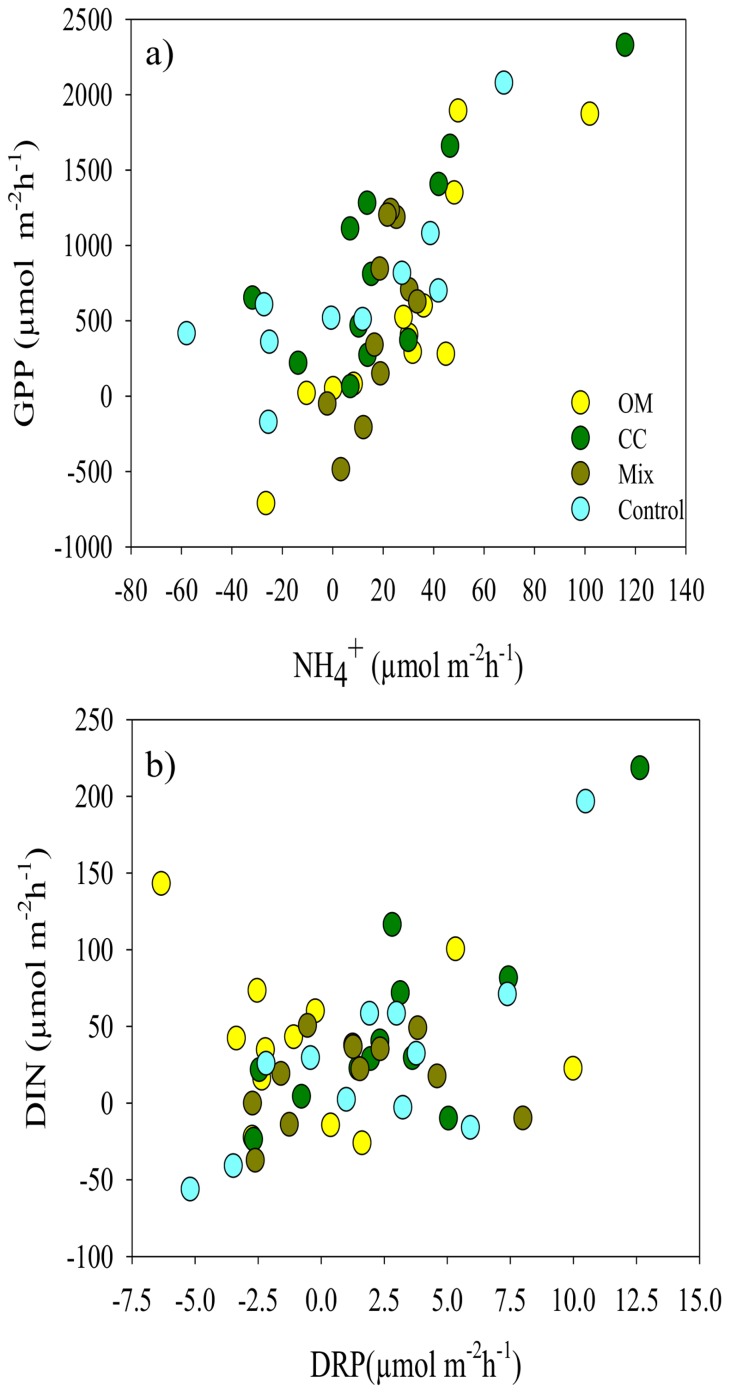
Relationship between main biogeochemical coupled processes (raw data).The top panel (a) shows the general relationship between gross primary production (GPP, µmol O2 m−2h−1) and ammonium uptake (µmol NH4
+-N m−2h−1) across the sampling area. The bottom panel (b) shows the relationship between dissolved inorganic nitrogen uptake (µmol DIN m−2h−1) and dissolved reactive phosphorus (µmol DRP m−2h−1) across the sampling area. Treatments: Organic Matter, Calcium carbonate, Mix, Control.